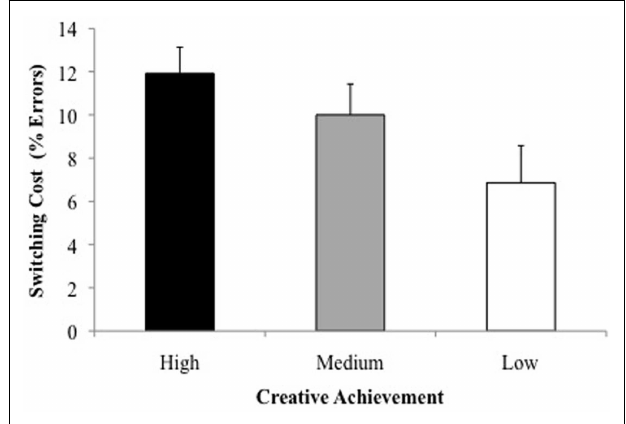
FIGURE 1 | Experiment 2: switching cost (percent errors) for high, medium, and low creative achievers. Error bars represent standard